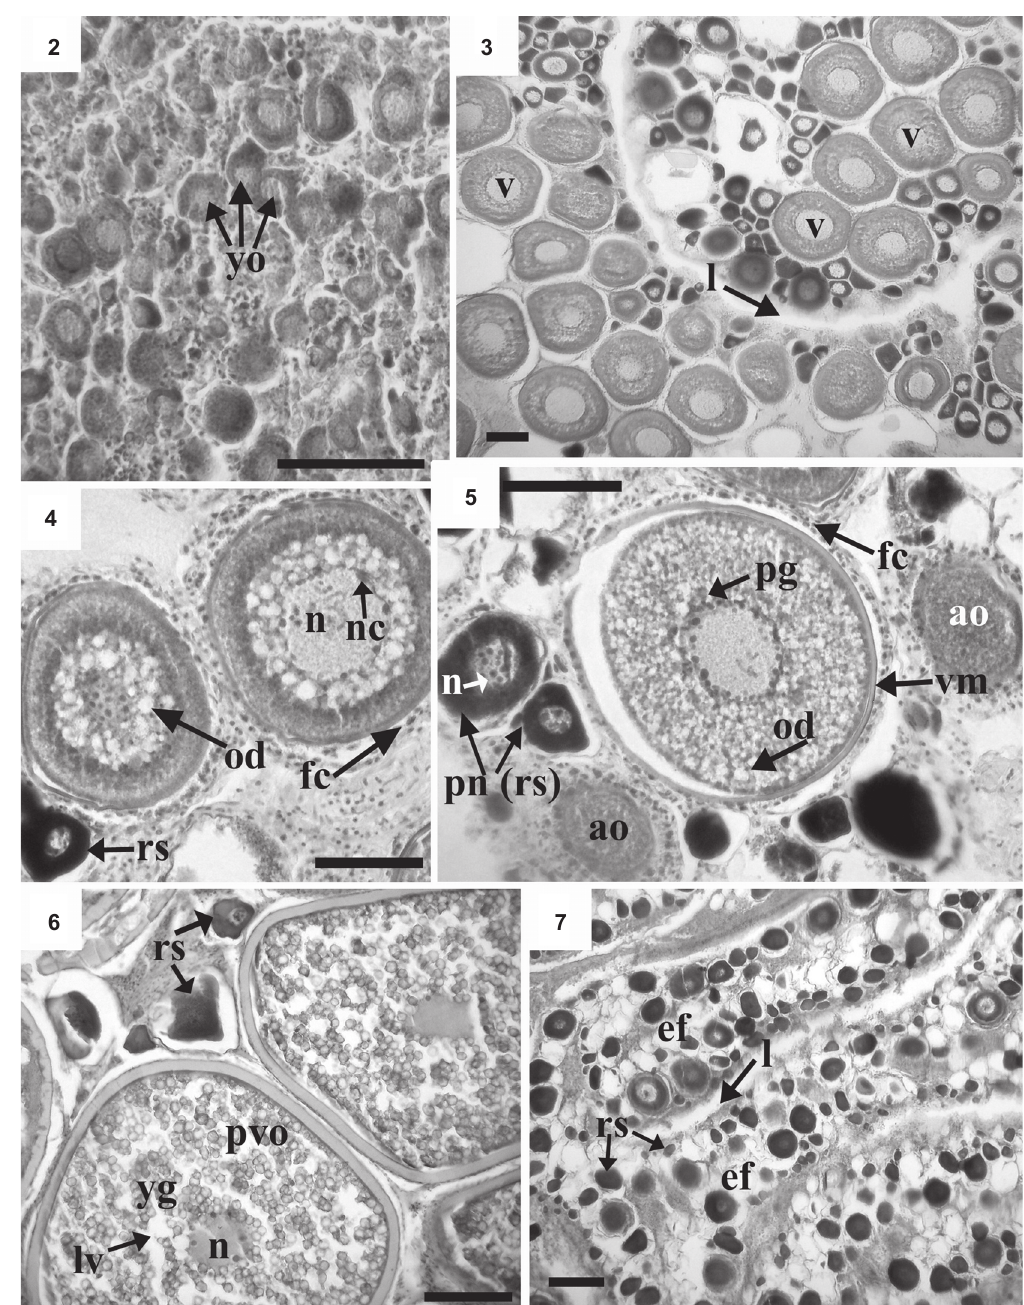
Figures 2-7. Histological sections of ovary at different maturity stages of Mugil liza from Sepetiba Bay: (2) immature ovary containing germ cells and young oocytes; (3) ovary during the vitellogenesis process; (4) developing ovary containing lipid vitellogenesis oocytes; (5) maturing ovary containing lipid and protein vitellogenesis; (6) ripe/running ripe ovary containing post-vitellogenic oocytes; (7) recovering/resting ovary containing empty follicle. (gc) Germ cells, (yo) young oocytes, (rs) reserve stock – peri-nucleolus stage, (v) vitellogenic oocyte, (l) lamella, (pn) peri-nucleolus stage, (fc) follicular cells – forming follicular layer, (n) nucleus, (yg) yolk globule, (nc) nucleolus, (od) oil droplet, (pg) protein granules, (vm) vitelline membrane, (ao) atretic oocyte, (pvo) post-vitellogenic oocytes, (lv) lipid vesicles, (ef) empty follicle. Scale bars: (2) = 50 µm, (3, 4 and 7) = 100 µm, (5 and 6) = 150 ZOOLOGIA 27 (3): 331–340, June, 2010